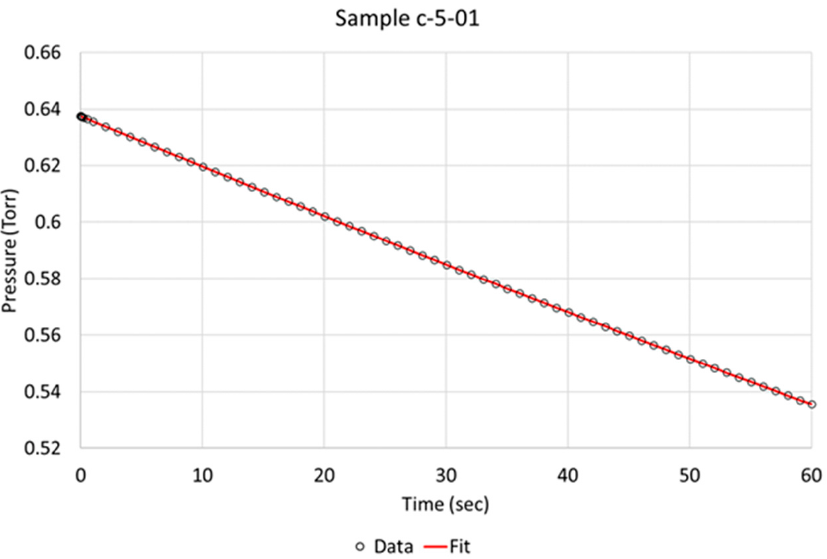
Figure 3. Berkeley Madonna fit of model to observed data indicated by circles for NPG sample c-5-01 (activated).